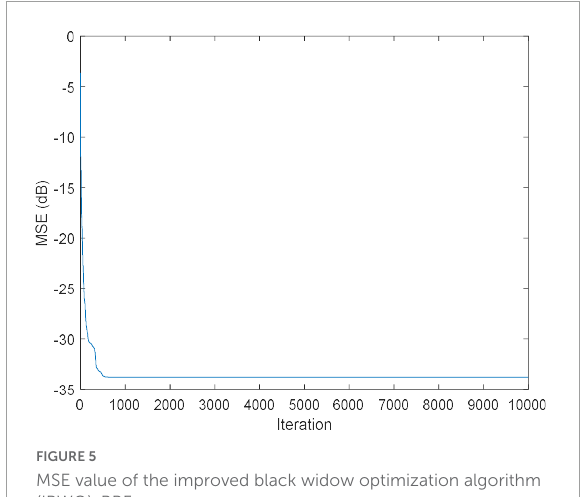
FIGURE6 Approximation results of the improved black widow optimization algorithm